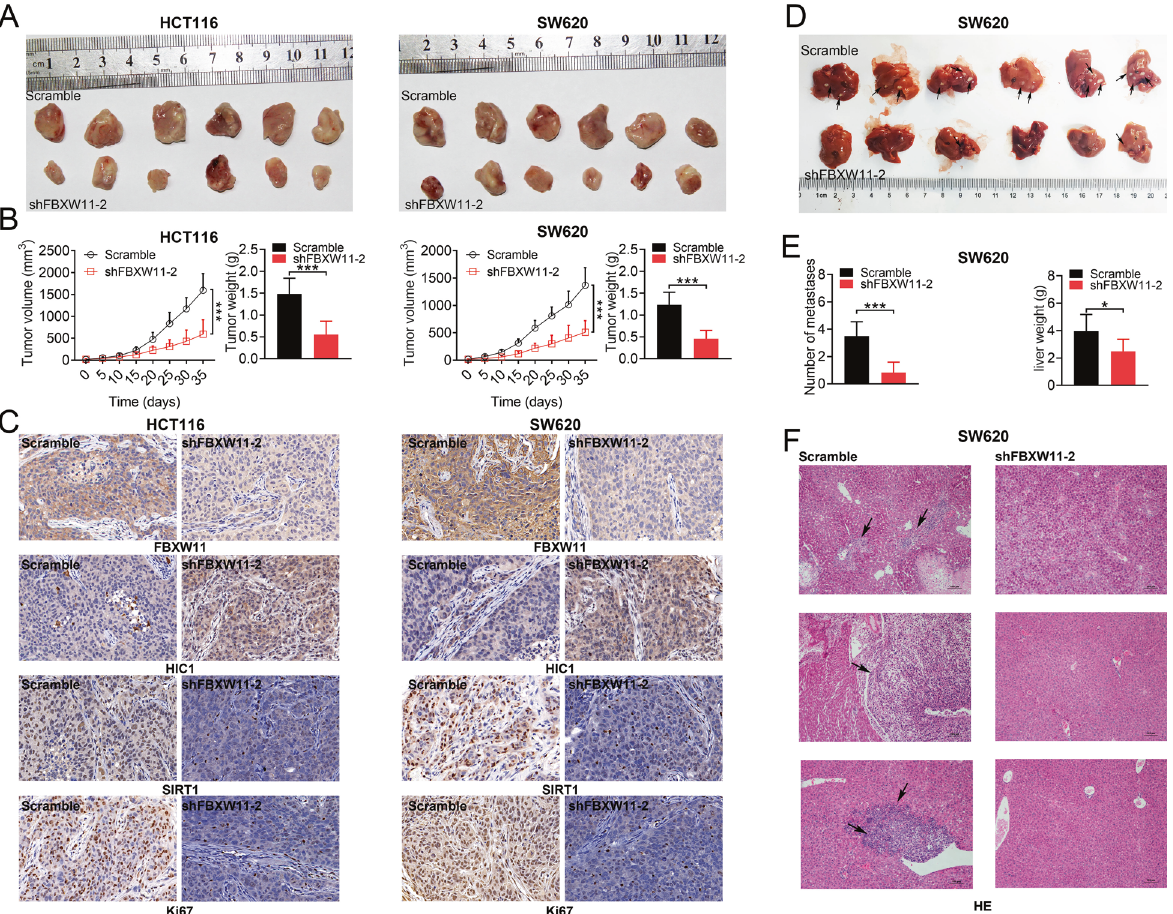
Fig. 7 Effect of FBXW11 knockdown on colorectal tumor growth and liver metastasis. A – C A mouse CRC xenograft model was established by injecting male BALB/c nude mice with transfected CRC cells into the subcutaneous region of the fl ank ( n = 6 per group). Tumor growth was monitored for 35 days. A Tumor xenografts were collected and weighed at the end of the experiment. B Tumor volume was recorded every 5 days and a growth curve was plotted. C Tumor tissues were sectioned and immunostained FBXW11, SIRT1, HIC1, and Ki-67 (200× magni fi cation). D – F A splenic liver metastasis model was established by injecting male BALB/c nude mice with transfected CRC cells into the spleen ( n = 6 per group). At 3 weeks post implantation, mice were killed and livers were collected. D Black arrows indicate metastatic foci in the liver. E The number of metastases was counted and the liver was weighed. F Liver tissues were sectioned and stained for H&E. Black arrows indicate metastases. Student ’ s t -test was used for statistical comparisons between two